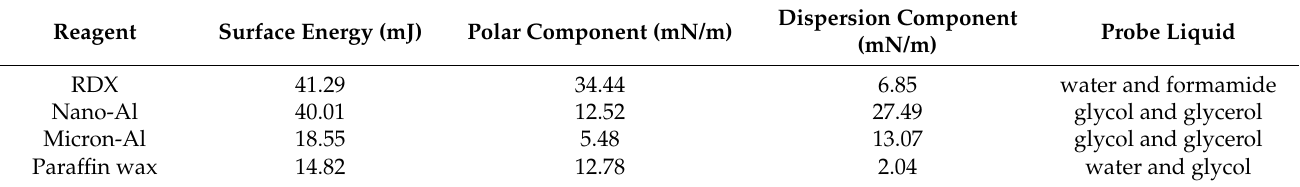
Table 5. Surface energy of each explosive component.